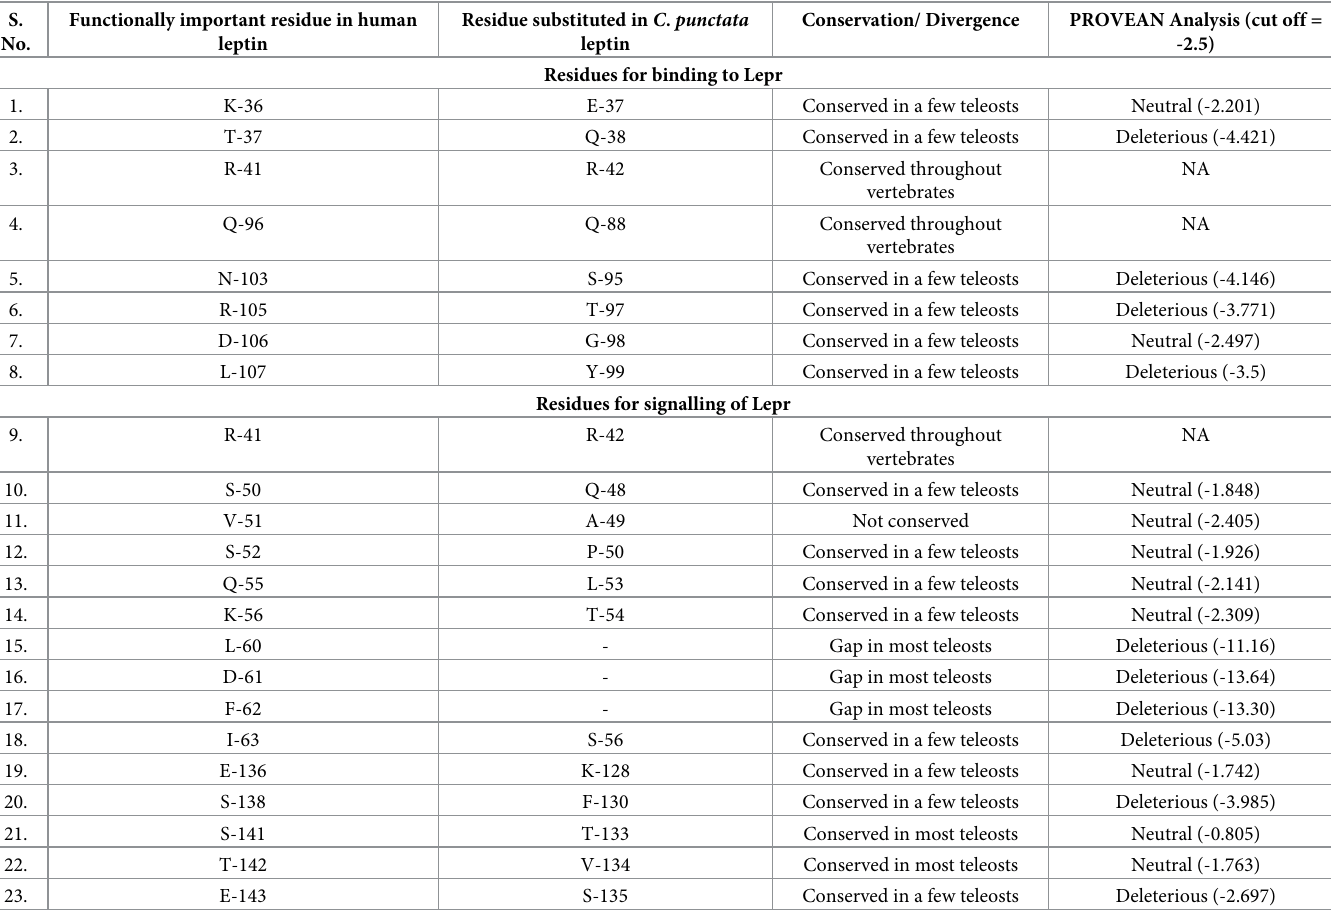
Table 2. Predicted effect of substitution/deletion in functionally significant sites of leptin of Channa punctata . S.